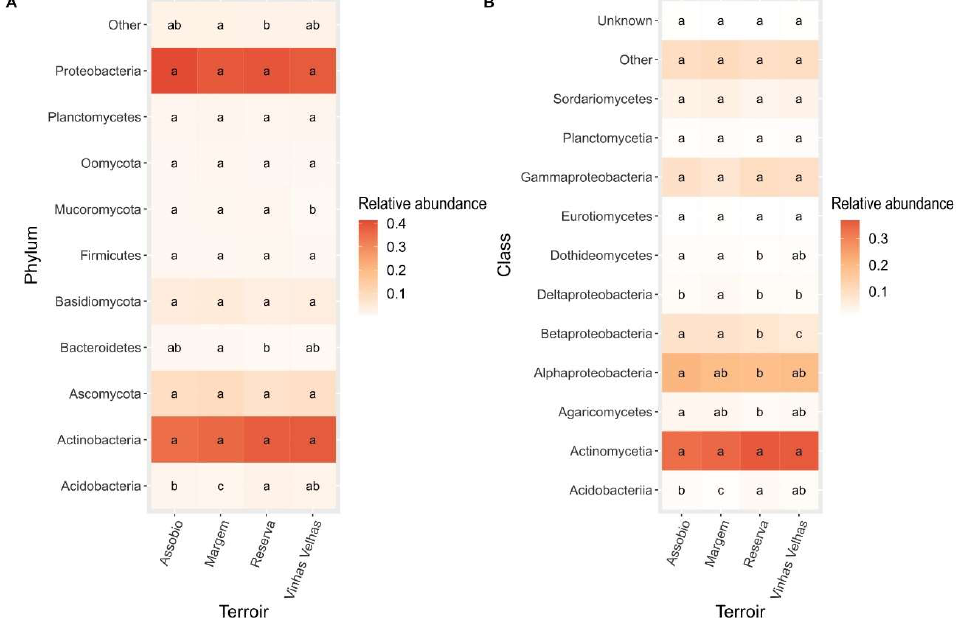
Figure 3. Relative abundance of Phylum ( A ) and Class ( B ) in each terroir. Letters denote significant differences at p < 0.05 between terroirs by Kruskal-Wallis test coupled with a post hoc Fisher’s test with a Bonferroni correction adjustment method. The taxa shown are the most abundant (detection of 0.005 for phylum and 0.01 for Class; prevalence of 0.05). The remaining taxa are included in the “Other” category. Unknowns correspond to the Class without taxonomical Classification in taxonomic ID.